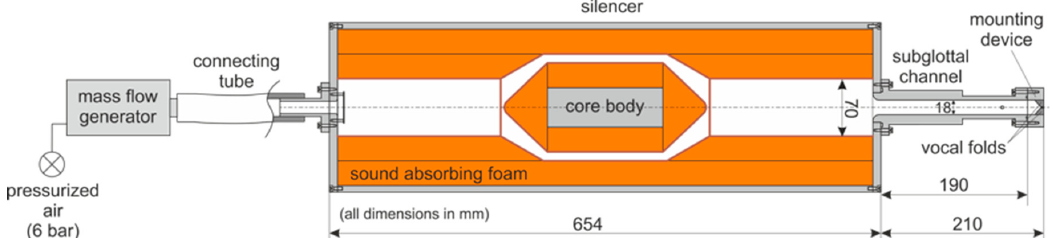
Figure 3. (Color online) (A) Schematic diagram of the synthetic larynx model including the mass flow generator, silencer, subglottal channel, and mounting device for the synthetic vocal folds (distances are in millimeters).